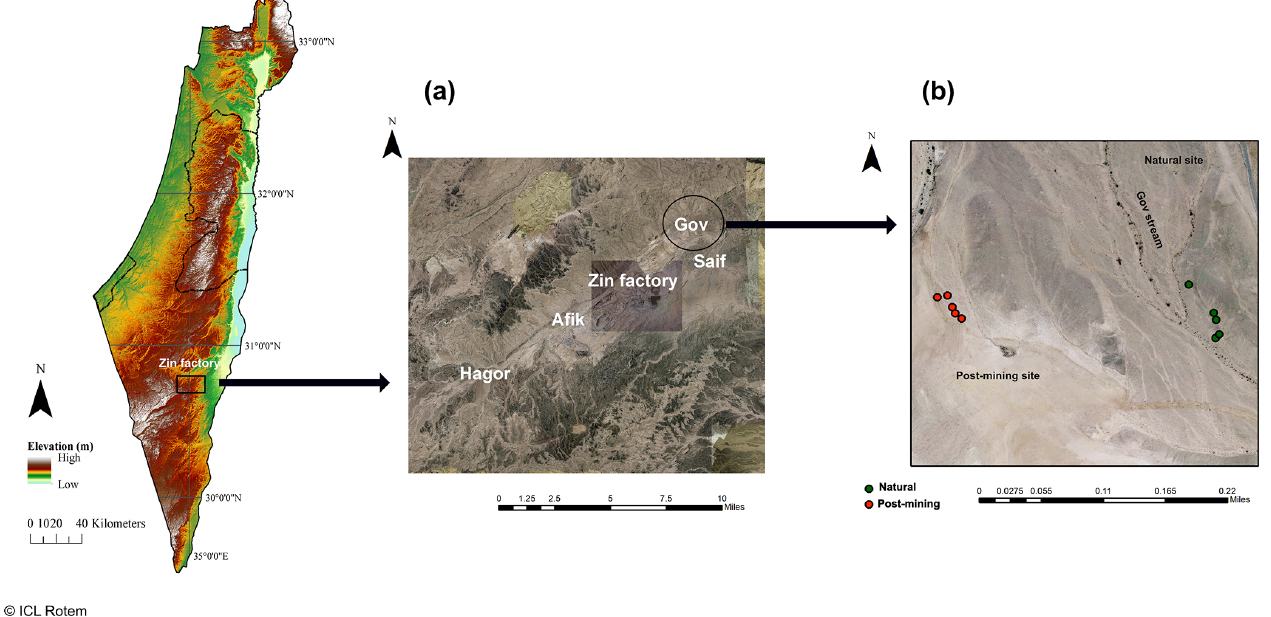
Figure 1. Map of the research area. Map (a) shows the different post-mining sites around the Zin factory. Map (b) shows the biocrust sampling points in Gov mining site used for this research. Green dots represent the natural biocrusts, and red dots represent the post-mining